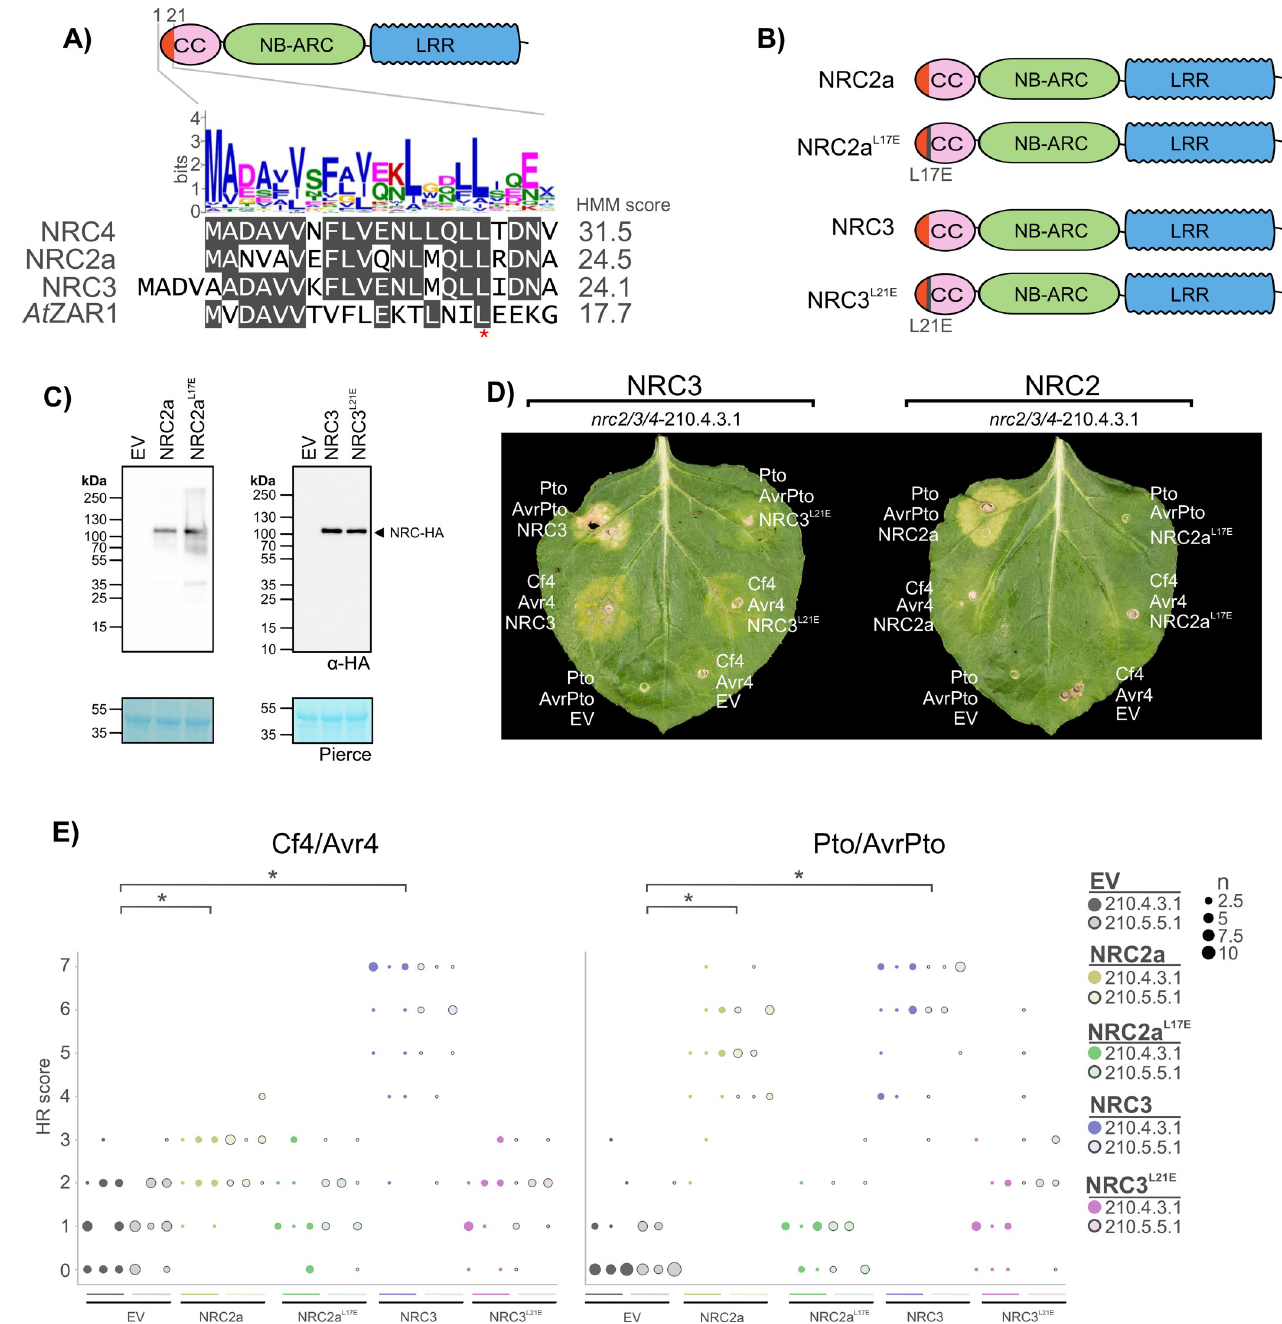
Fig 3. The N-terminal MADA motif of NRC3 is required for Cf-4/Avr4-triggered hypersensitive cell death. A ) NRC3 has an N-terminal MADA motif. Alignment of NRC2, NRC3, NRC4 and ZAR1 N-terminal MADA motif with the consensus sequence pattern of the MADA motif and the HMM score for each sequence. B ) Schematic representation of NRC2, NRC3, and the respective NRC2 L17E and NRC3 L21E MADA mutants. C ) NRC2 and NRC3 MADA mutants accumulate to similar levels as wild-type proteins. Immunoblot analysis of transiently expressed C-terminally 6xHA-tagged NRCs 5 days after agroinfiltration in wild-type N . benthamiana plants. D ) NRC MADA mutants do not complement Cf-4/Avr4 or Pto/AvrPto-triggered hypersensitive cell death in the N . benthamiana nrc2/3/4 lines. Representative N . benthamiana leaves infiltrated with appropriate constructs were photographed 7–10 days after infiltration. The NRCs tested, NRC2 and NRC3, are labelled above the leaf of nrc2/3/4 -210.4.3.1. The receptor/effector pair tested, Cf-4/Avr4 and Prf (Pto/AvrPto), are labelled on the leaf image. A representative leaf of the independent nrc2/3/4 -210.5.5.1 line is shown in S7E Fig ) Quantification of hypersensitive cell death. Cell death was scored based on a 0–7 scale between 7–10 days post infiltration. The results are presented as a dot plot, where the size of each dot is proportional to the count of the number of samples with the same score within each biological replicate. The experiment was independently repeated three times. The columns